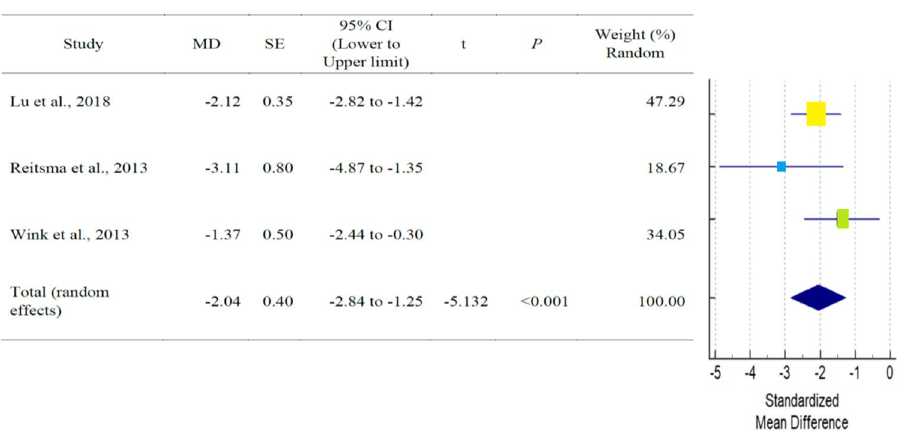
Figure 4. Forest plot for the outcome of SNA.